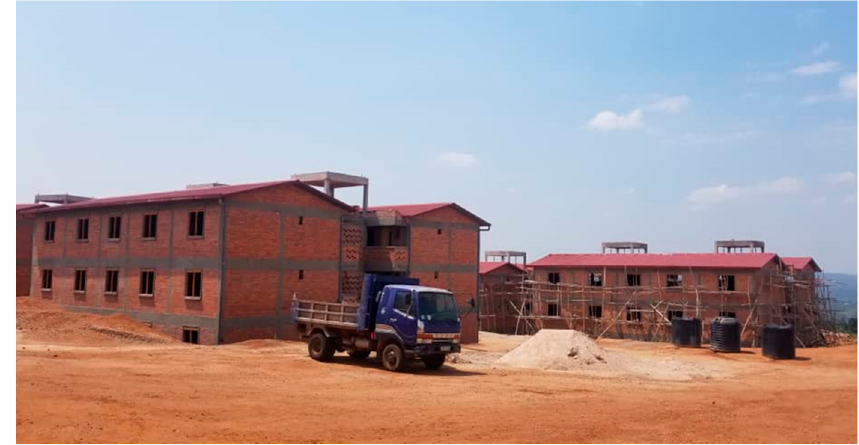
Figure 2. Location of research sites and Busanza resettlement site. Source: Authors. 283